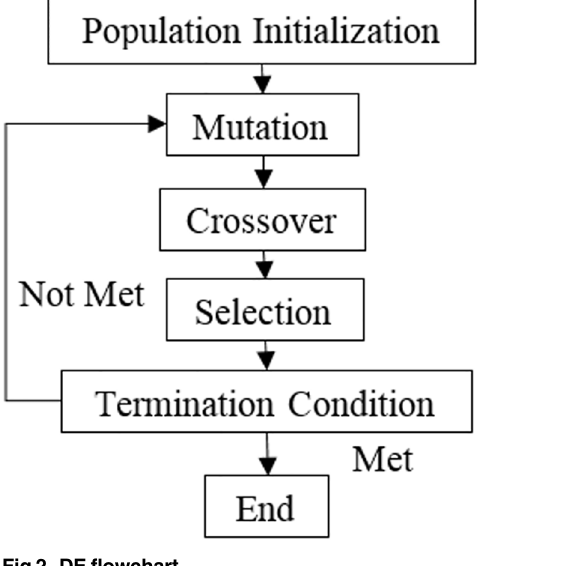
Fig 2. DE flowchart.